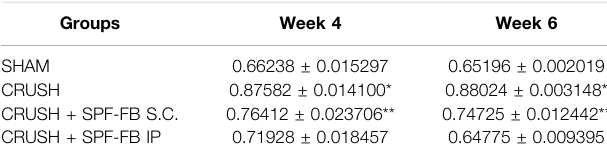
TABLE 1 | G-ratio was determined as the ratio of the axon diameter to the fi ber diameter.